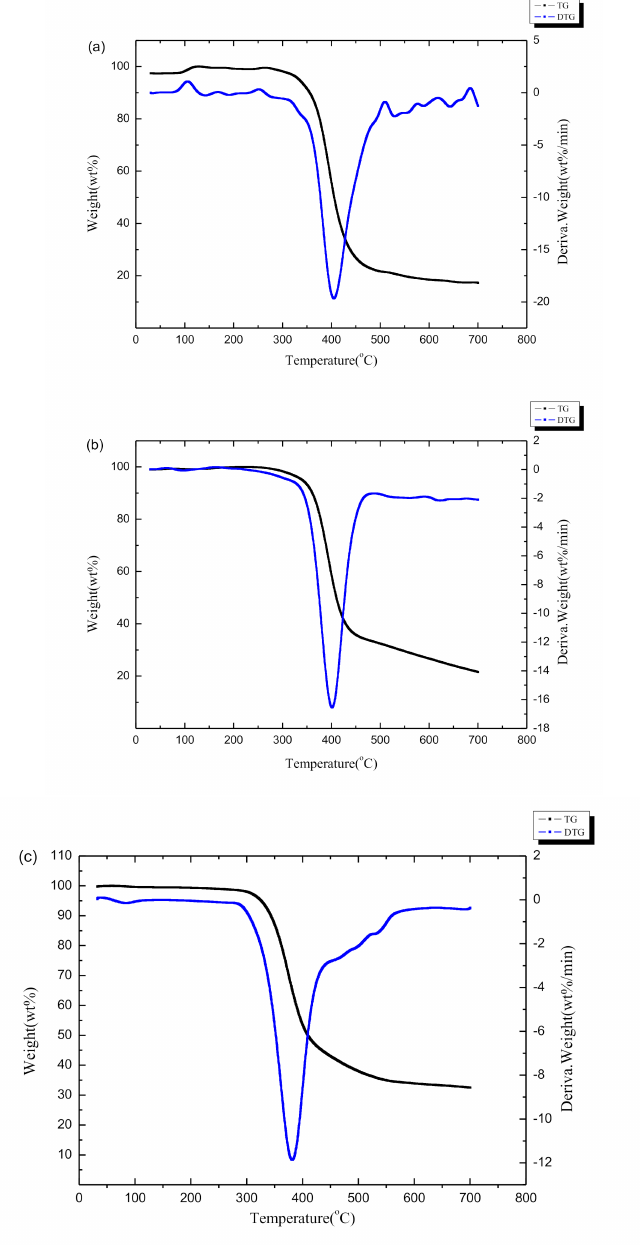
Figure 5. TG and DTG curves of ( a ) EP, ( b ) Al-lignin20 / EP and ( c ) F-lignin@APP20 / EP. Thermogravimetric analysis (TGA) data of epoxy resin (EP), Al-lignin 20 / EP